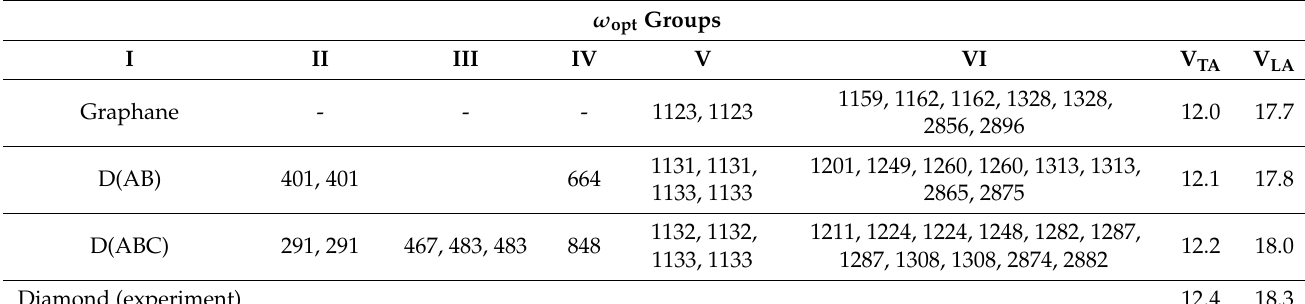
Table 2. Phonon frequencies (cm − 1 ) at the Γ -point region and velocities of transverse and longitudinal acoustic in-plane modes (10 3 m/s) [20].